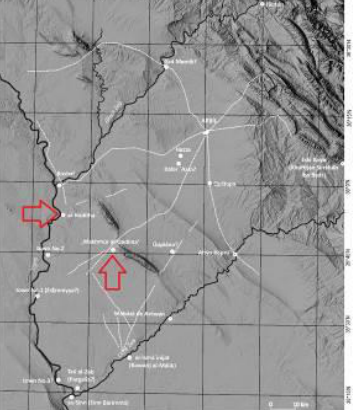
Figure 1 - Area of interest map as seen on Google Earth (a) and a closer view with detected historical sites